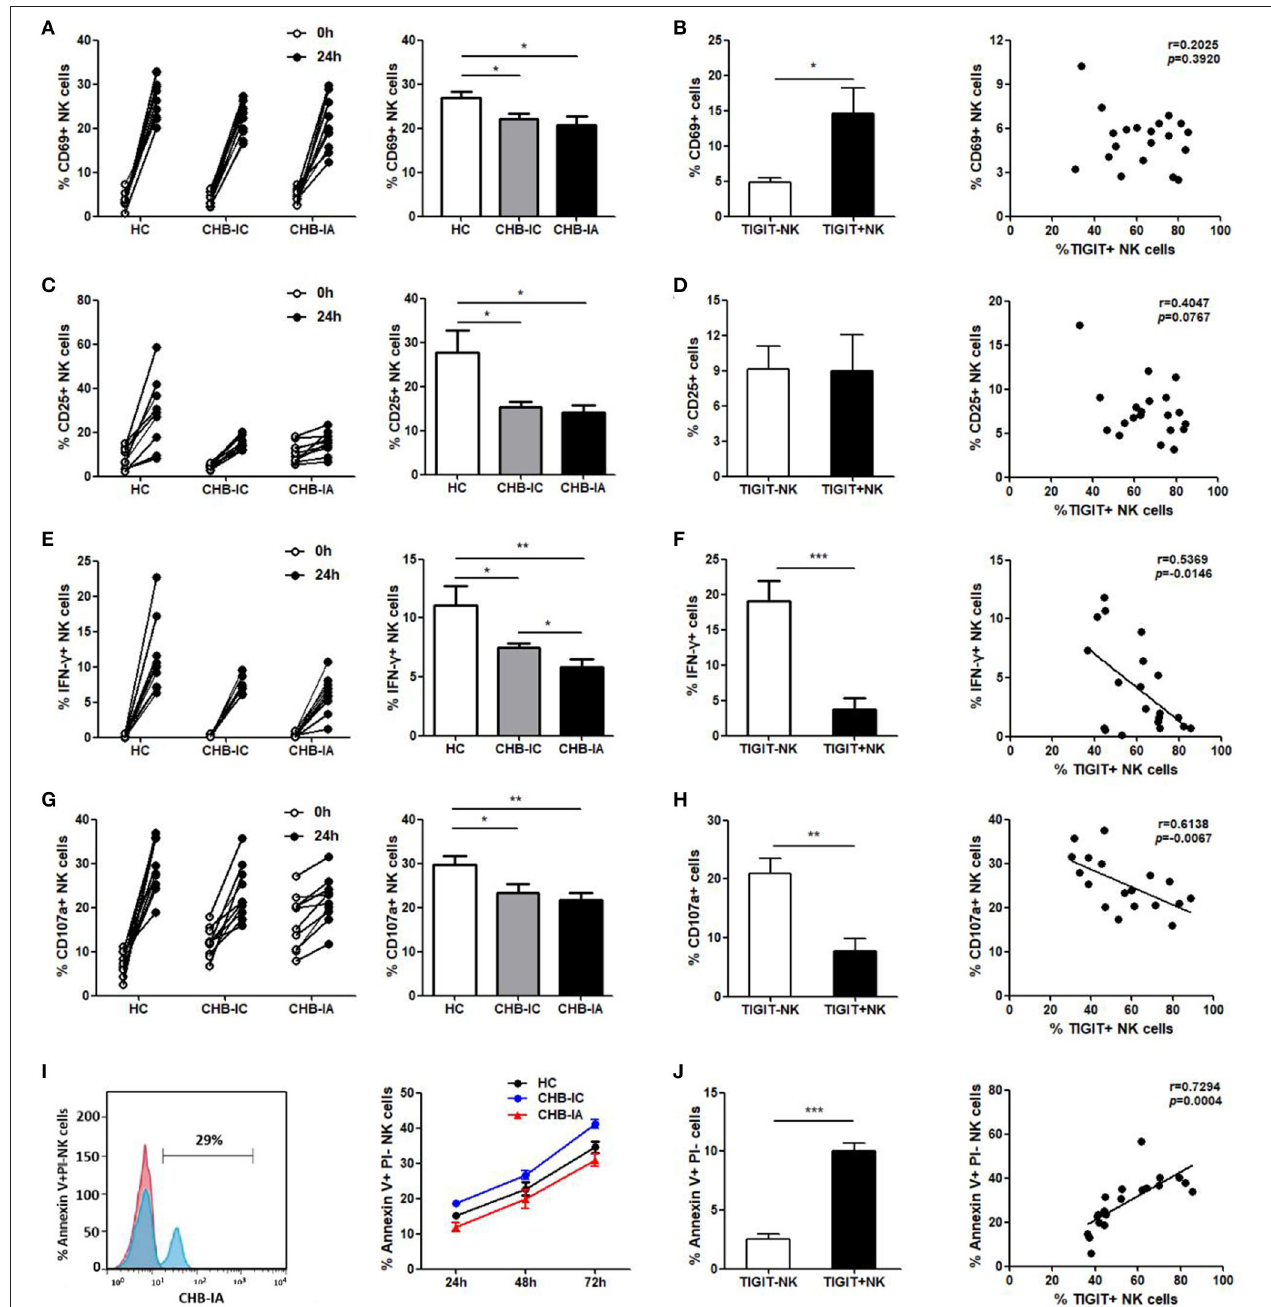
FIGURE 3 | Correlations of TIGIT expression with the function of NK in different groups of the study. PBMCs isolated from CHB-IA, CHB-IC and healthy individuals were stimulated with LPS (A–D) or IL-12 (E, F) for 24h. (A,C) The percentages of CD69 + (A) or CD25 + (C) NK cells before and after stimulation with LPS in the three groups were evaluated by flow cytometry. Data are expressed as the mean ± SEM (n = 8–15 subjects per group) and are from a single experiment representative of three. * p < 0.05 (Mann-Whitney U test). (B,D) The percentages of LPS-stimulated CD69 (B) or CD25 (D) on TIGIT- or TIGIT + NK cells was measured by flow cytometry. Correlation between TIGIT expression and percentages of LPS-stimulated CD69 (B) or CD25 (D) on NK cells is also shown (Spearman’s rank). (E) The percentages of IFN- γ in NK cells before and after stimulation with IL-12 in the three groups were evaluated by flow cytometry. Data are expressed as the mean ± SEM (n = 10). (F) The percentages of IL-12-stimulated IFN- γ in TIGIT- or TIGIT + NK cells was measured by flow cytometry. Data are shown as the mean ± SEM (n = 10). Correlation between TIGIT expression and percentages of IL-12-stimulated IFN- γ in NK cells is also shown (Spearman’s rank). (G,H) PBMCs were stimulated with IL-12 in the presence of K562 cells for 24 h. (G) The percentages of CD107a + NK cells before and after stimulation with IL-12 in the three groups were evaluated by flow cytometry. Data are expressed as the mean ± SEM (n = 8–10 subjects per group). (H) The percentages of CD107a on TIGIT- or TIGIT + NK cells was